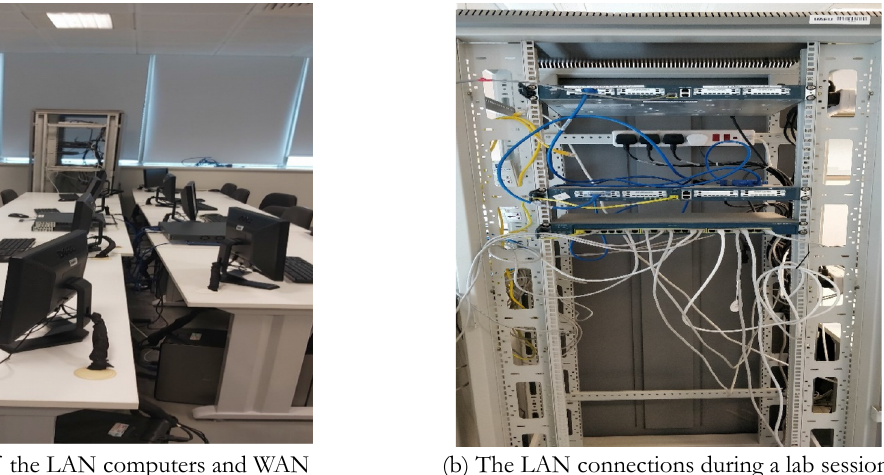
Figure 1. The computer networking laboratory setup